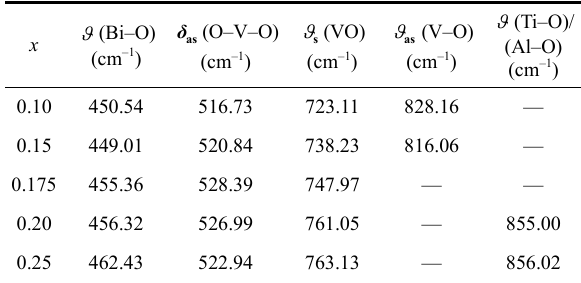
Fig. 3 FT-IR spectra of Bi 2 V 1– x Al x /2 Ti x /2 O 5.5– δ (0.10 ≤ x ≤ 0.25). Table 3 Characteristics bands of BIMEVOX materials from FT-IR